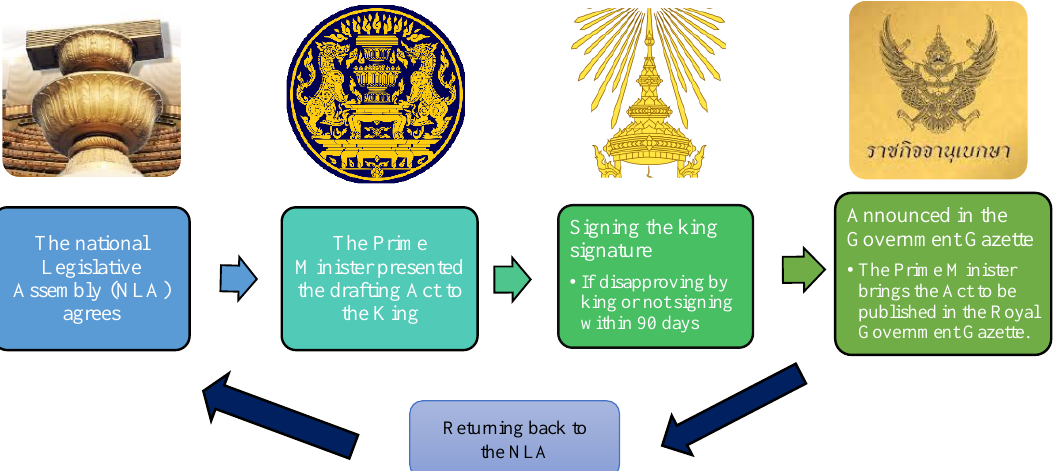
Figure 7. Workflow of the Royal Thai Legal Act Enactment